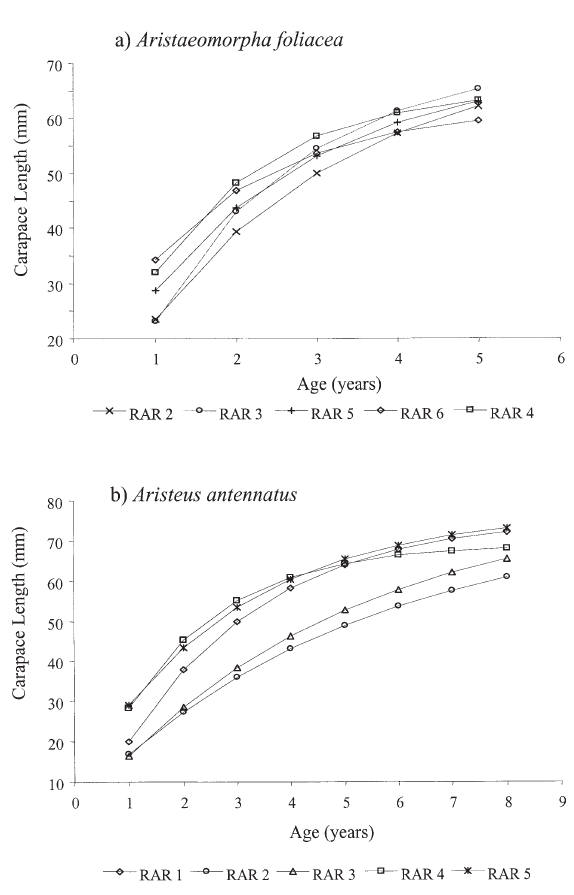
F IG . 8. - Von Bertalanffy growth curve of females for each RAR: a) Aristaeomorpha foliacea, b) Aristeus